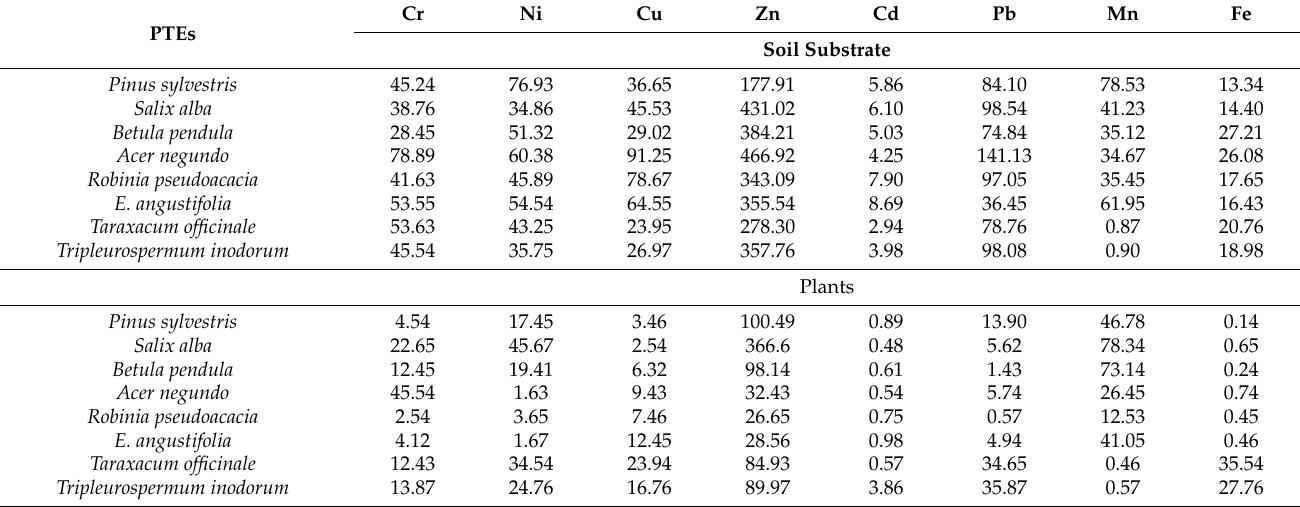
Table 2. The content of PTEs in the soil of the replanted area, as well as on the harvested plant parts. PTEs